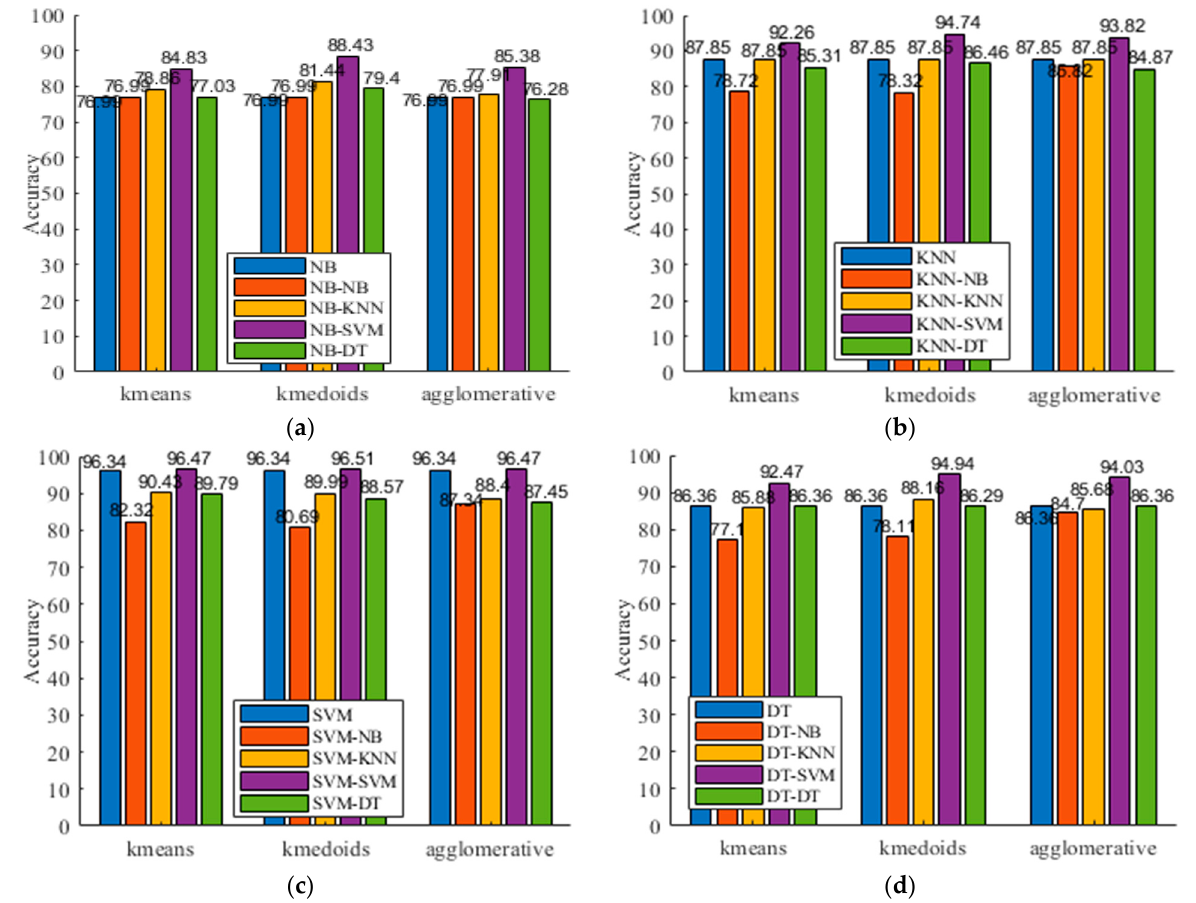
Figure 8. Recognition accuracy vs. different clustering algorithms on UCI-HAR. ( a ) NB; ( b ) KNN; ( c ) SVM; ( d ) DT. Table 7. F1 of different clustering algorithms on